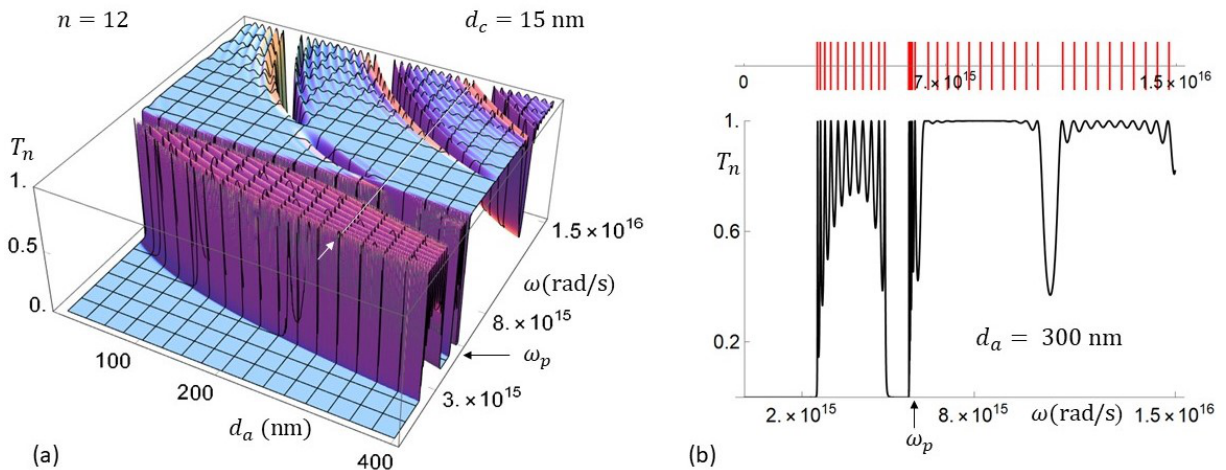
Figure 10. Transmission coefficient as a function of ω and d a , for a metallic superlattice with n = 12, d c = 15 nm and θ i = π /3. In subfigure ( a ), the bands move to lower frequencies as d a grows. In subfigure ( b ), we see more clearly the resonant transmission for a fix value of the conductor layer width d c . In the upper part of subfigure ( b ), bands and resonances predicted by the resonant dispersion relation (39).